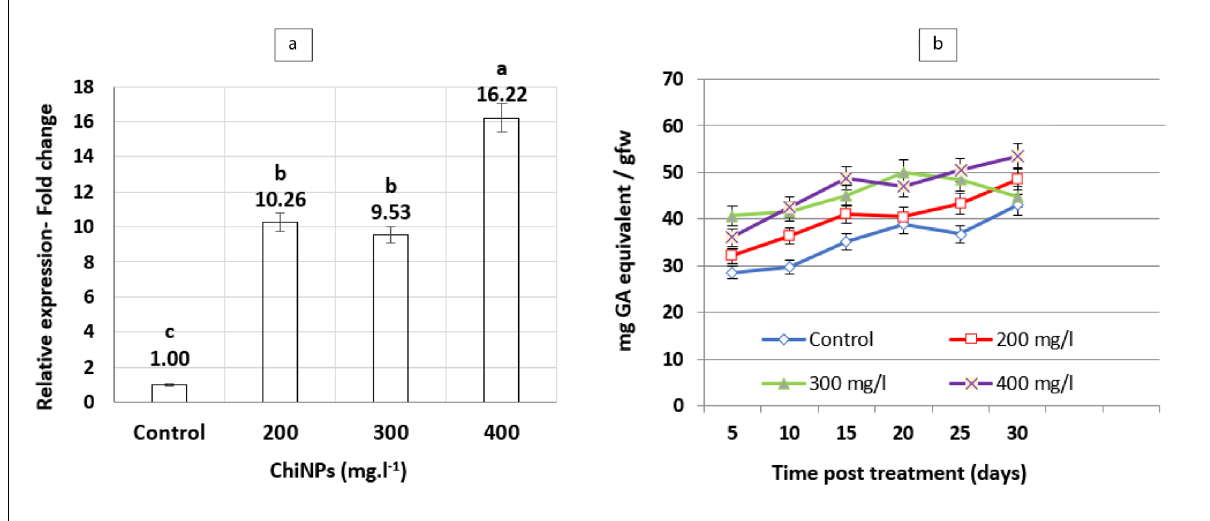
Figure 7: (a) Expression pattern analysis of pathogenesis-related gene 1 (PR-1) in response to three tested concentrations of chitosan nanoparticles (ChiNPs) and an untreated control. Values with the same letters are not significantly different ( p ≤0.05). (b) Phenolic dynamic curve in faba plants treated with three tested concentrations compared to the untreated control faba bean plants. Table 2: Vegetation parameters of faba bean plants treated with chitosan nanoparticles and chitosan bulk polymer at six tested concentrations compared to untreated healthy and infected control plants Chitosan nanoparticles Chitosan bulk polymer Concentration (mg/L) Shoot length (cm) Leaf area (cm 2 ) Chlorophyll index Shoot length (cm) Leaf area (cm 2 ) Chlorophyll index Untreated infected control 27.31±1.44 e 9.73±0.65 b (0.00) Untreated healthy control